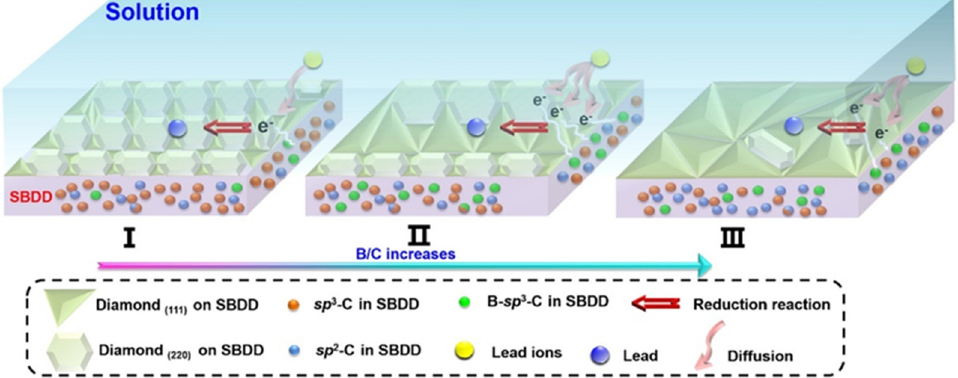
Figure 8. Schematic of the influence mechanism of B/C ratio on the detection performance of SBDD electrode for Pb 2+ (reproduced with the permission of [90]).